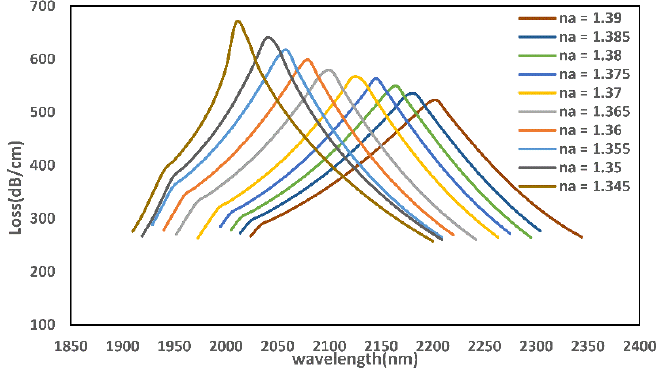
Figure 7. Loss curve of the sensor at different 𝑛 (cid:3028) .